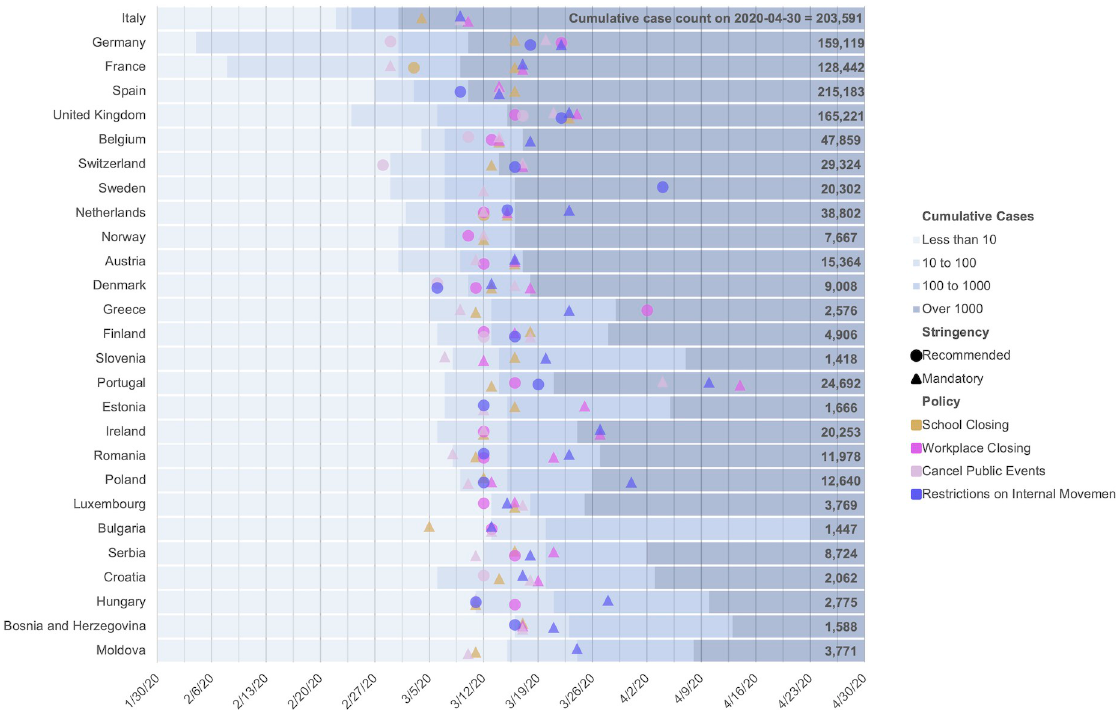
Fig 1. Timeline of major COVID-19 policy interventions by country. In response to the COVID-19 pandemic, European countries enacted a series of national policies intended to promote social distancing that varied across countries in terms of time (with respect to both calendar time and reported cases), nature, and enforcement (mandatory versus non-mandatory). Policy type is indicated with color and if that policy was instituted as a mandatory or non-mandatory policy is indicated with